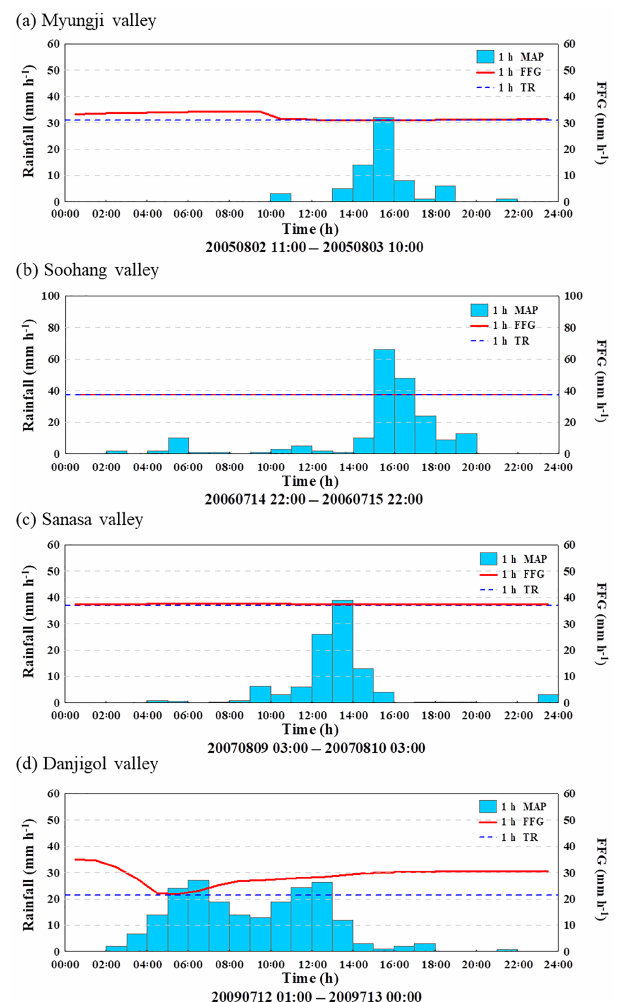
Figure 7. Threshold runoff (TR), mean areal precipitation (MAP) and estimated FFG (flash flood guidance) for selected flash flood